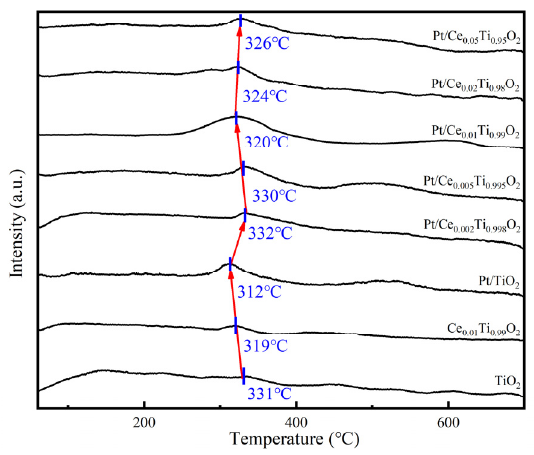
Figure 8. H 2 -TPR profiles of Pt/Ce x Ti 1 − x O 2 (x = 0, 0.002, 0.005, 0.01, 0.02, and 0.05) catalysts and Ce 0.01 Ti 0.99 O 2 and TiO 2 carriers.